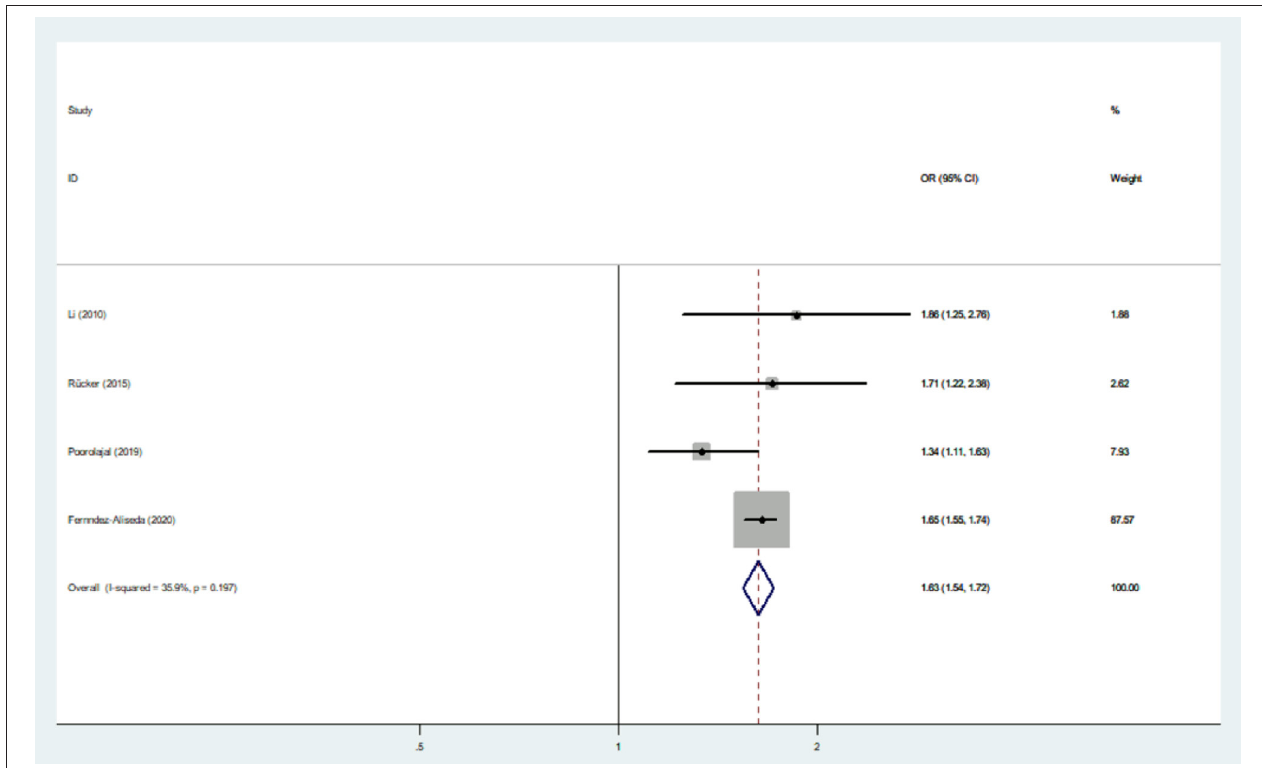
FIGURE 7 | Effect of IAD on smoking